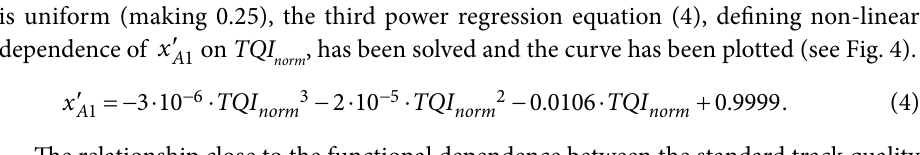
0.000.250.500.751.00 Fig. 4. The relationship between the variable 1 A x ′ of the first group A criterion describing the dependence of the railway trip quality on the railway track condition and TQI x ′ values (solid points) so that the curve of the function could run 1 A 1 x ′ = , through all standard TQI = 0, when smoothly from TQI 1 A norm 0 x ′ = . The standardized TQI values and the modelled TQI cally approach 1 A norm points) were described by various regression equations, such as linear ( y ) and fourth power ( y ) regression equations (see Fig. cubic ( y 3 4